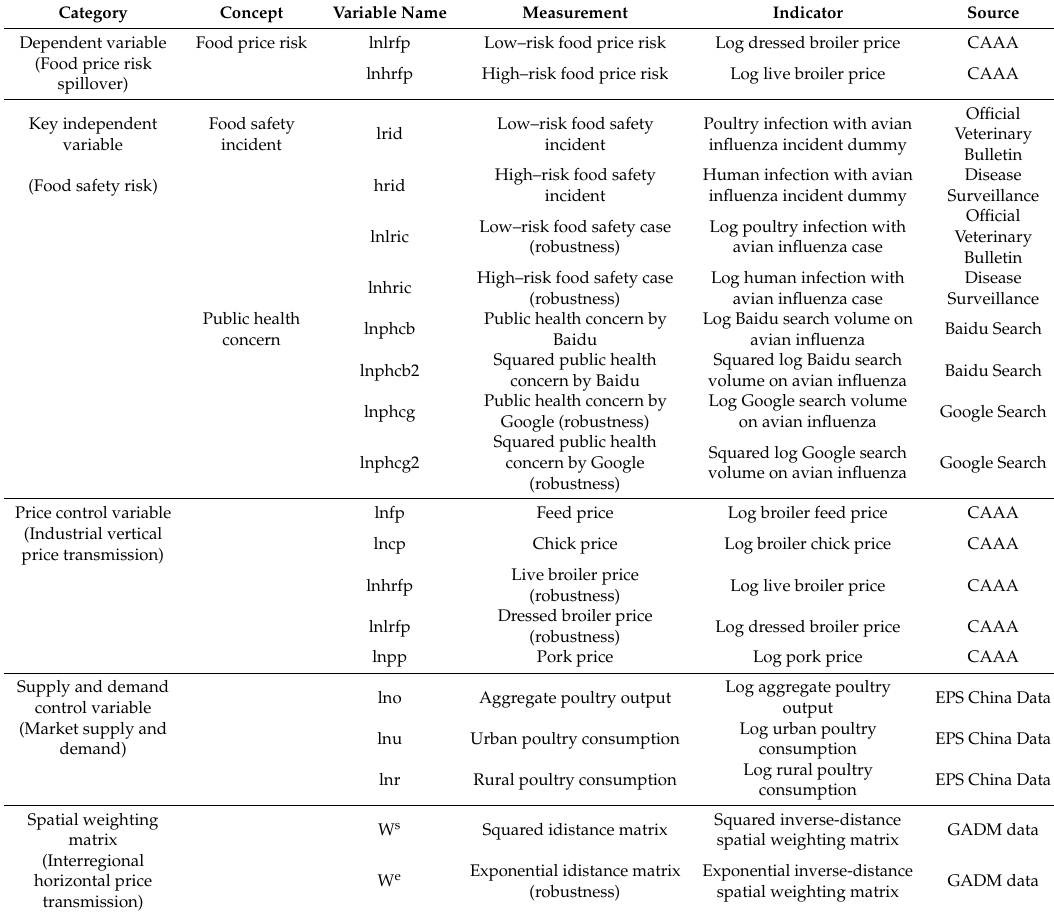
Table 2. Summary of variable measurements and data